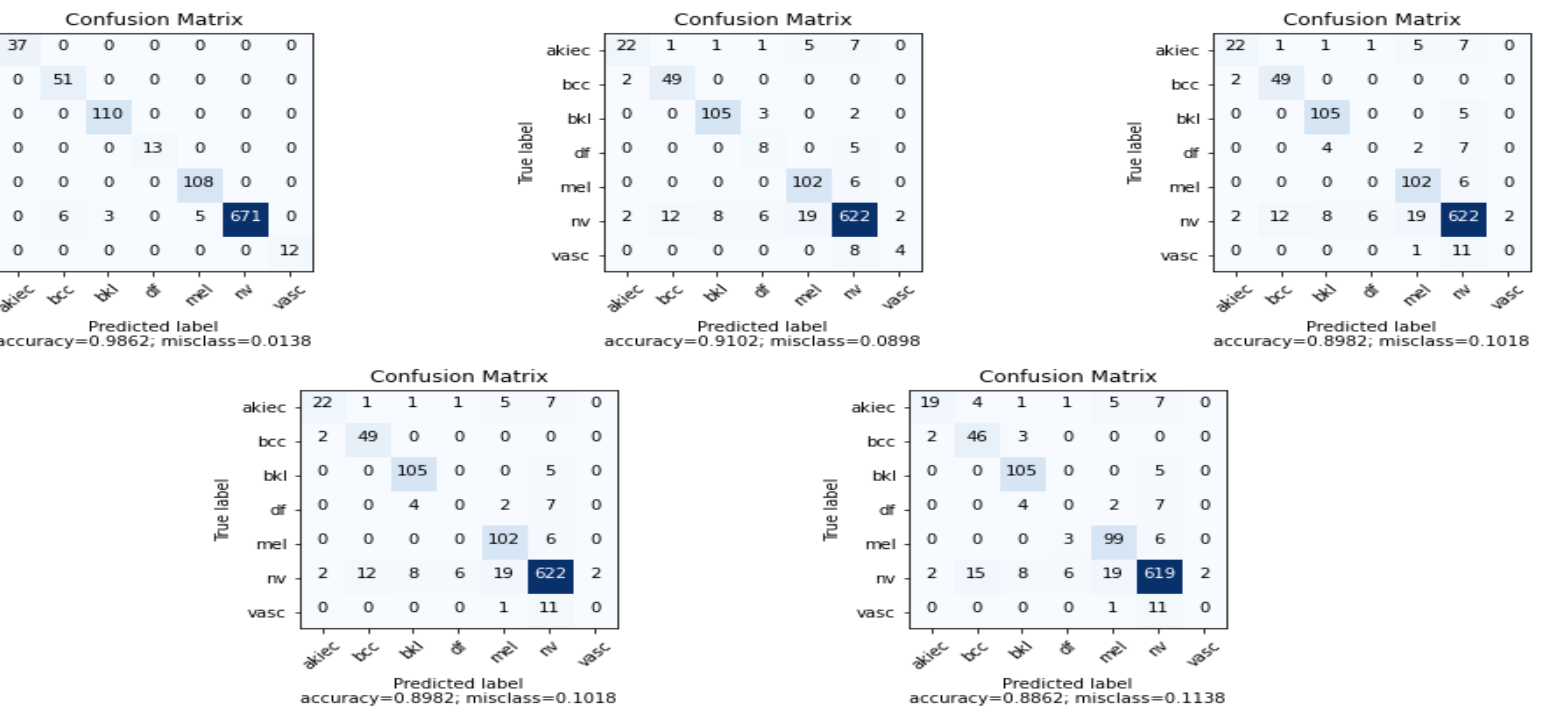
Figure 7. Skin disease classification confusion matrix using Proposed Model, EfficientNetB0, ResNet50, InceptionV3, and DenseNet121 (left to